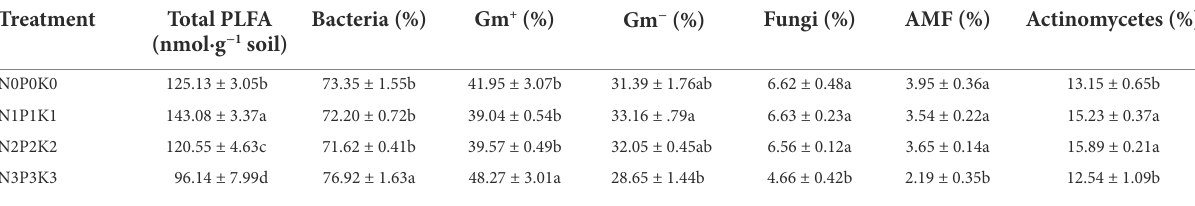
TABLE 3 The effects of different fertilization levels on soil total PLFA and percentage of microbial PLFAs.